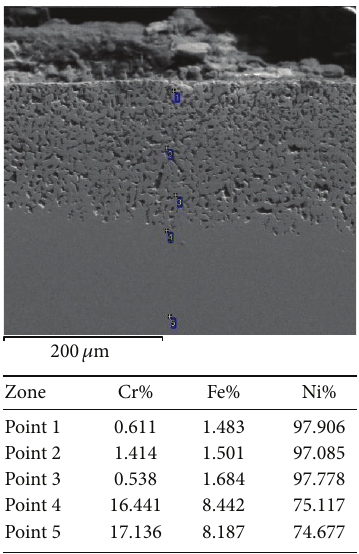
Figure 5: SEM image and EDS analysis of a cross-section of Inconel 600 after corrosion test at 700 ∘ C in NaCl-KCl mixture.